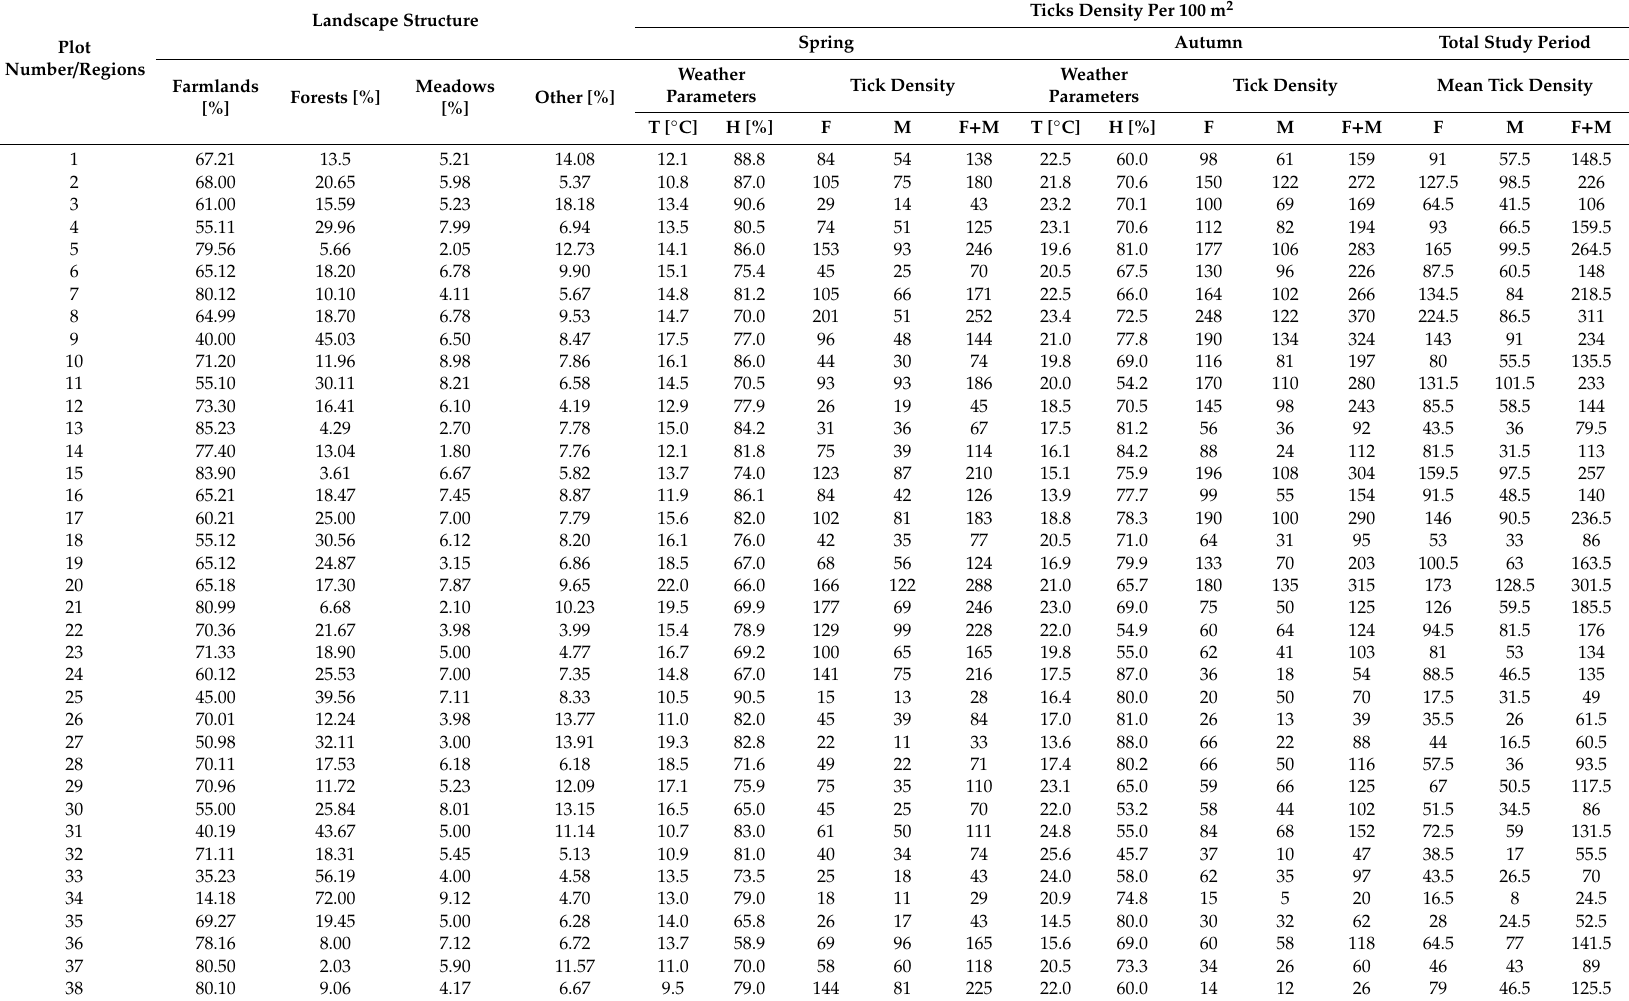
Table A2. Structure of land use and density of D. reticulatus ticks per 100 m 2 in the study area.